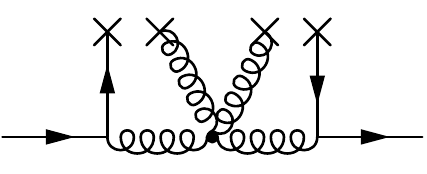
Figure 4 . Contribution of the dimension-eight Weinberg operator to the quark propagator. The operator insertion corresponds to the dotted vertex, interactions with the background are represented by crosses and quark propagators are depicted by solid lines.